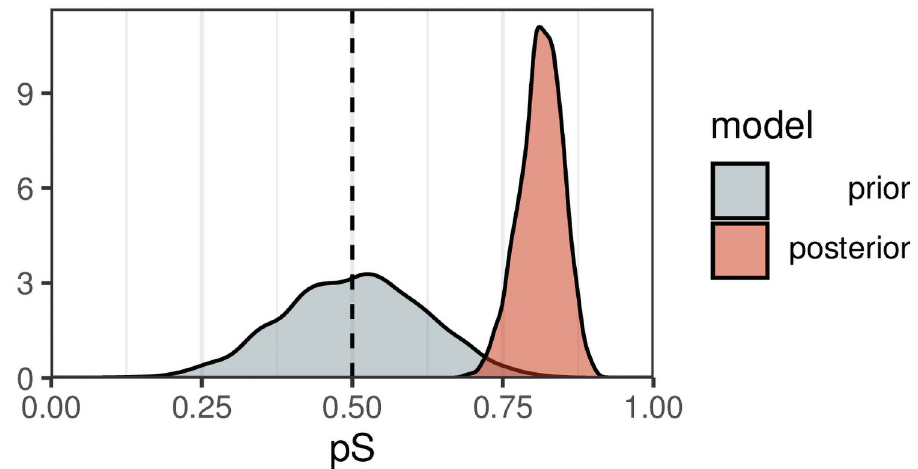
Fig 3. Prior and posterior probability distributions for p s for the chicken foraging data from Dawkins (1971).